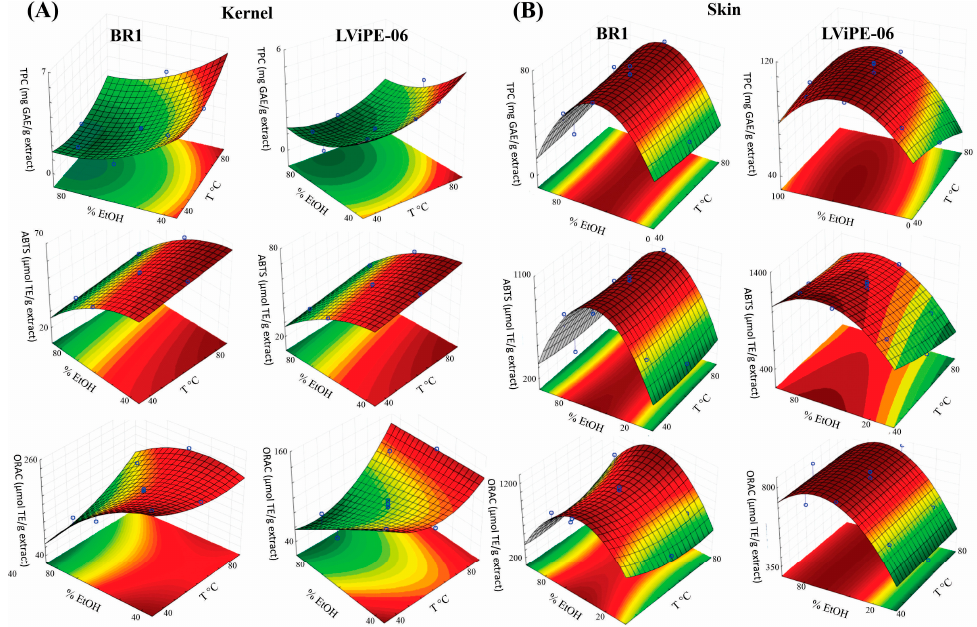
Figure 1. Three-dimensional response surface plots generated for kernels ( A ) and skins ( B ) of BR1 and LViPE-06 peanut genotypes assessed, showing the regions of higher antioxidant activity (red). Axis x corresponds to % EtOH, axis y corresponds to the temperature ( ◦ C), and axis z corresponds to the total phenolic content (TPC) or deactivation activity of ABTS • + or ROO • radicals (ABTS or ORAC,